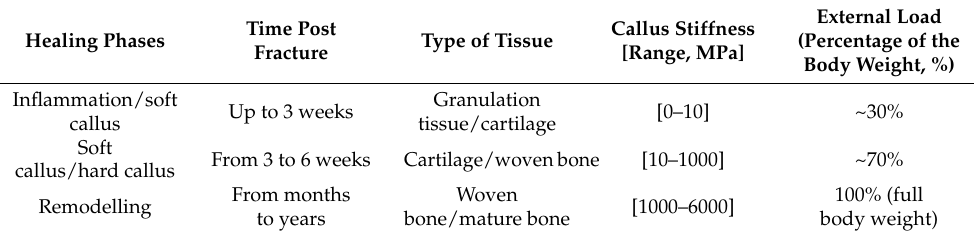
Table 1. Clinical indications for weight bearing during the bone healing